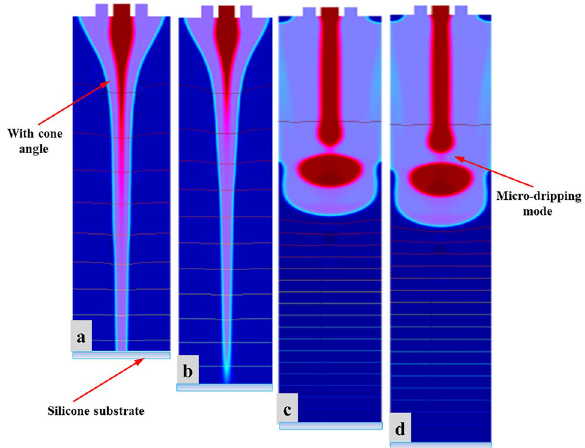
Figure 12. The simulation results of CE-Jet morphology with different coaxial needle-ground electrode distance at the same time ( a ) 10 cm ( b ) 12 cm ( c ) 14 cm and ( d ) 16